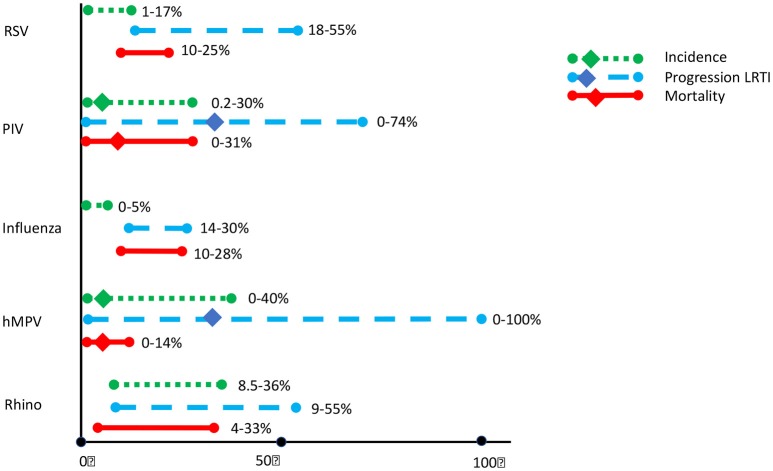
Incidence of common respiratory viral infections (CRV) and associated progression to Lower Respiratory Tract Infections (LRTI) and mortality in HCT recipients. Updated from Shah et al. (2012), based on (Versluys et al., 2010; Shah et al., 2012; Chemaly et al., 2014b; Campbell et al., 2015; Robinson et al., 2015; Fisher et al., 2017; Green, 2017).